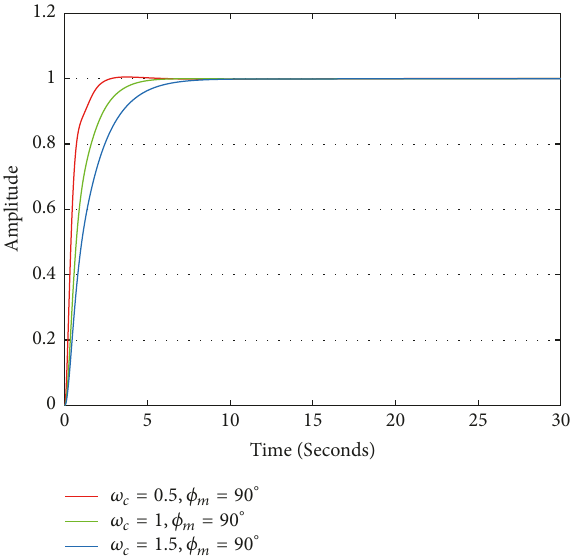
Figure 18: Step response of 𝑃 2 (𝑠) with the same 𝜙 𝑚 .